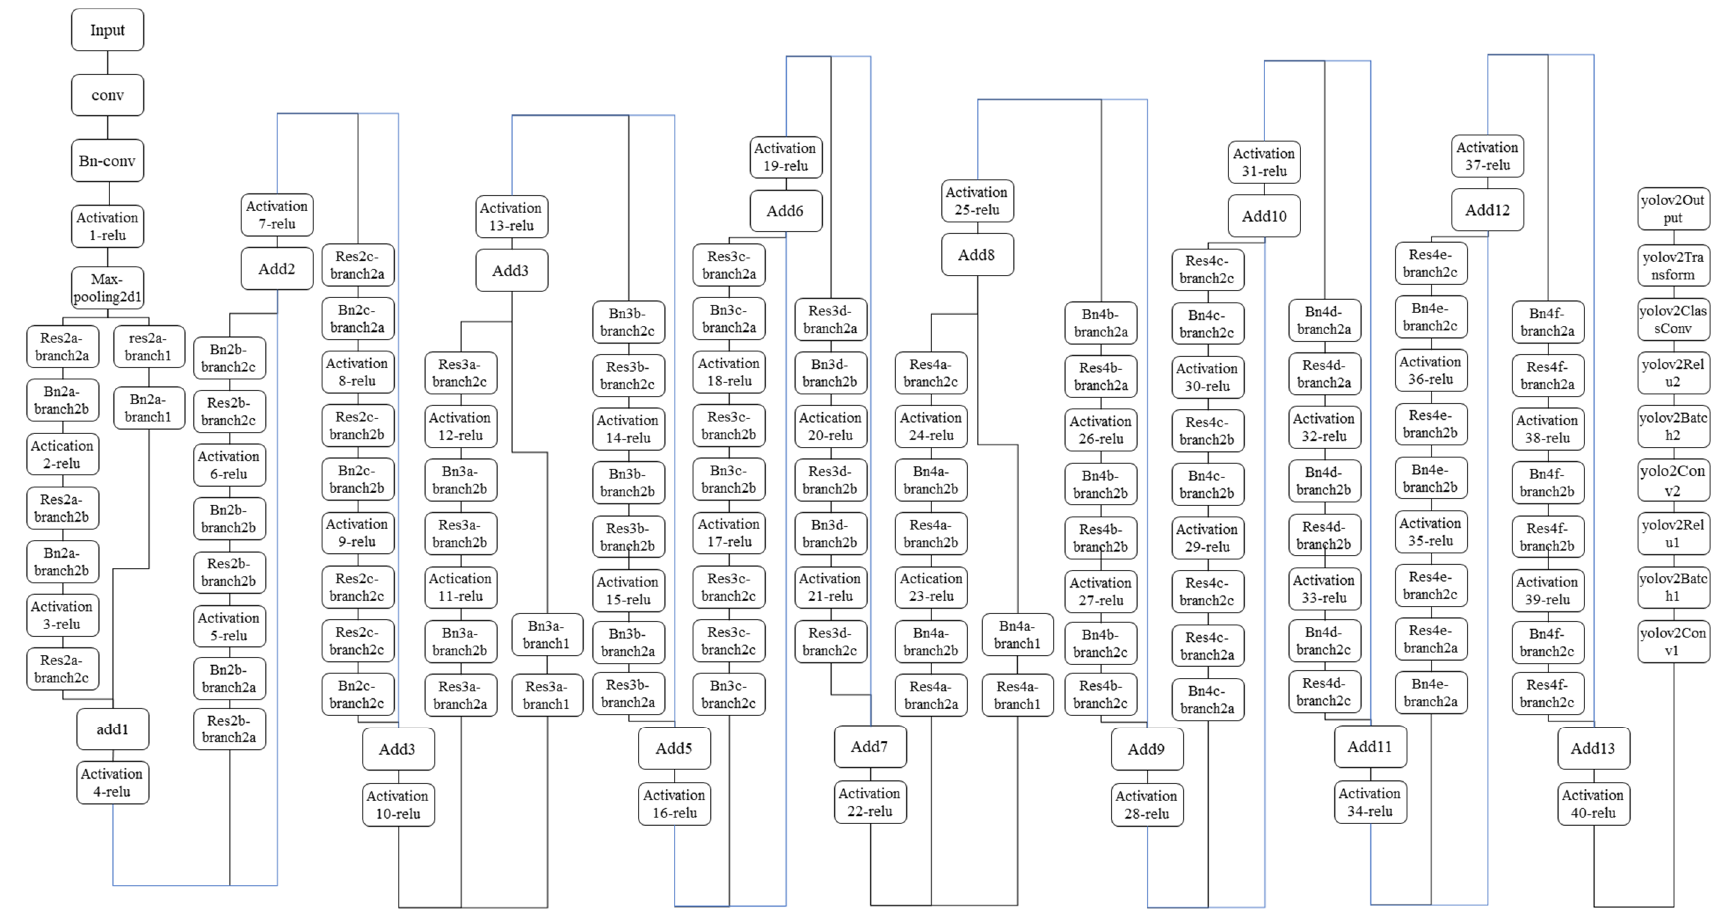
Figure A1. RES-YOLO Network Structure.